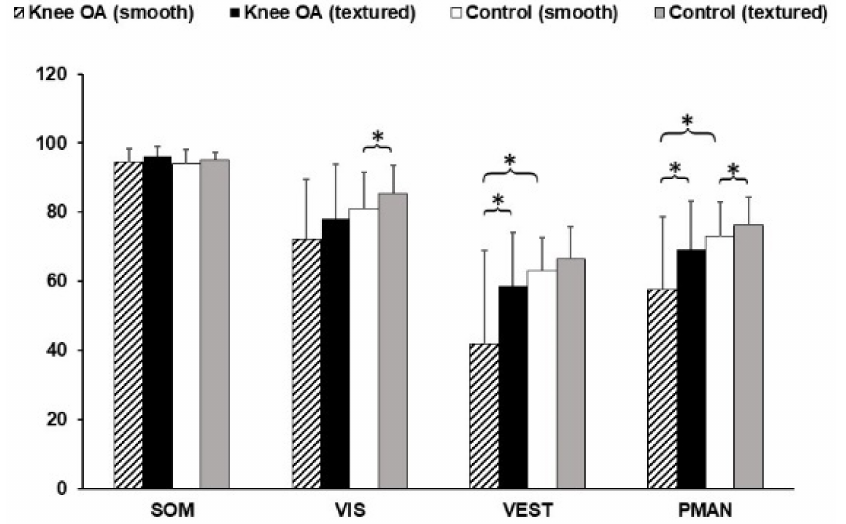
Figure 6. Results of sensory analysis ratios. * Statistically significant mean difference ( p <